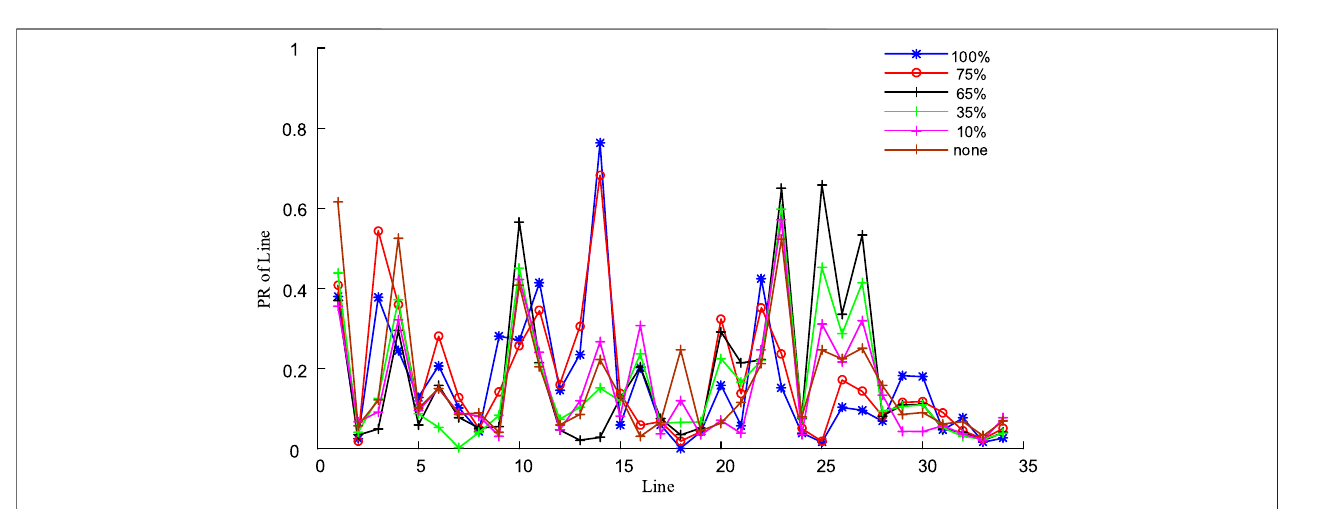
FIGURE 9 | Comparison of multi-time line identi fi cation results.